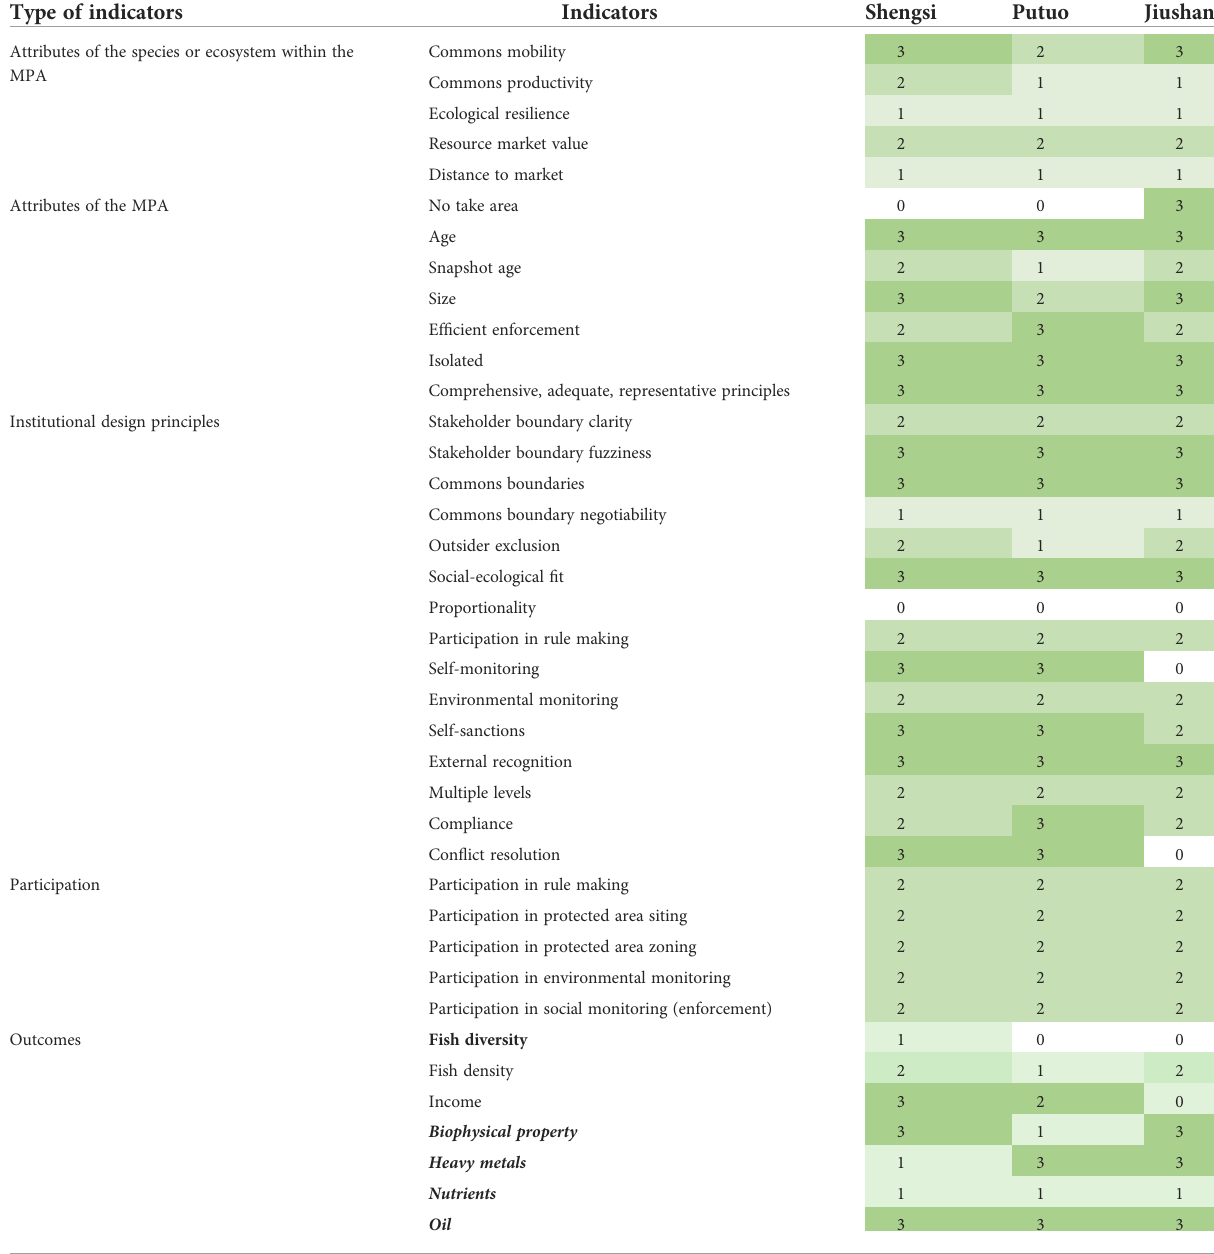
The darker the color, the higher the score. The shade of green indicates the level of the